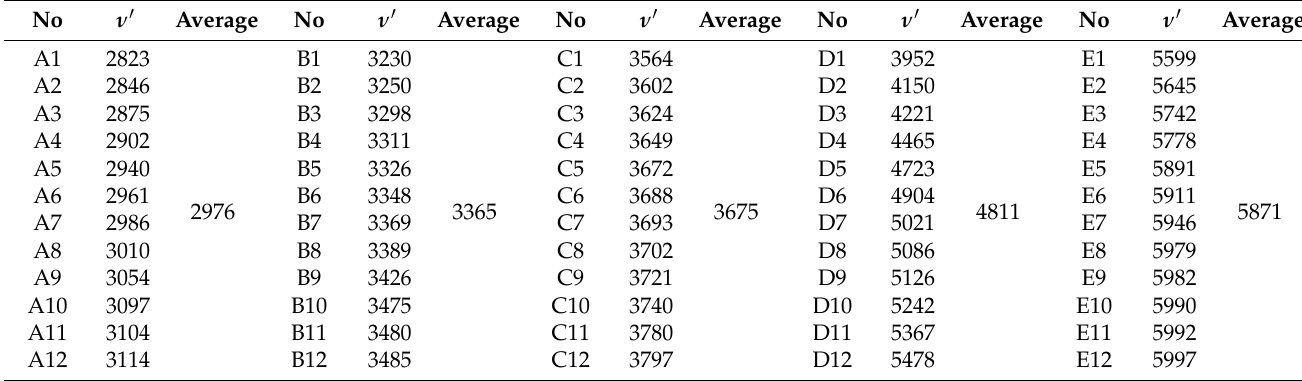
Table 3. Vertical wave velocities of five limestone specimen borehole locations.